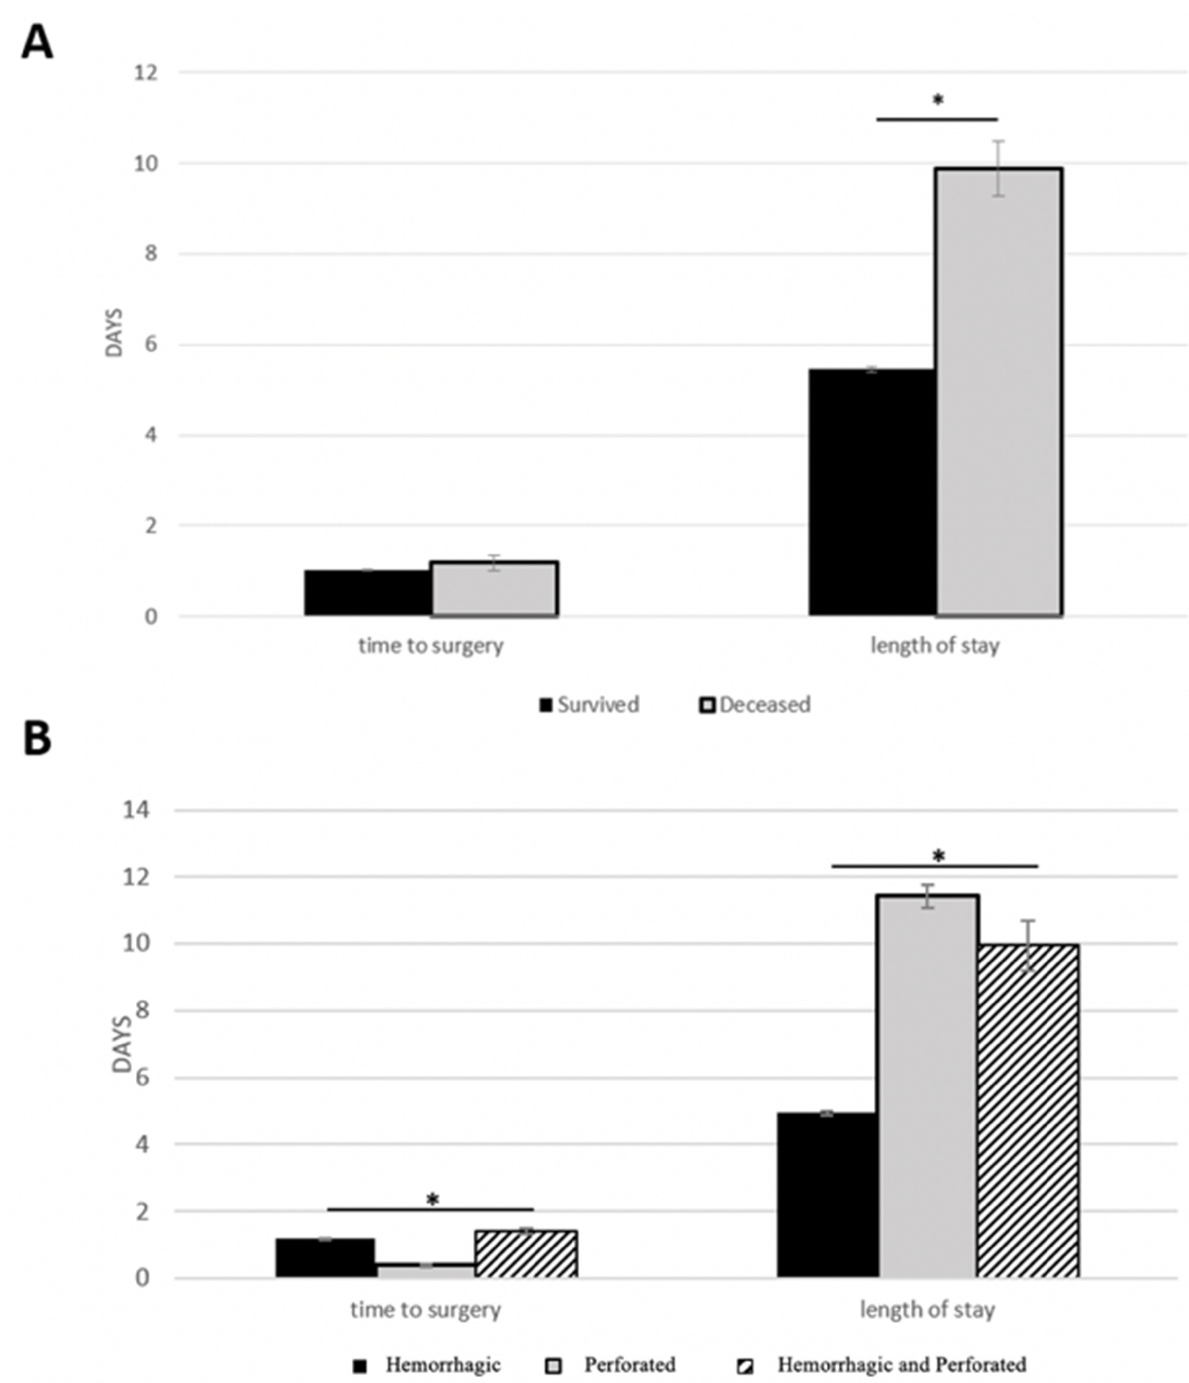
Figure 4. Time to Surgery and Hospital Length of Stay (HLOS) in elderly. Time to surgery and HLOS were plotted based on survival ( A ) and on ulcer type ( B ). An asterisk (*) indicates significance ( p < 0.05). The three subtypes of ulcers include: hemorrhagic ulcer, perforated ulcer, and both hemorrhagic perforated ulcers.